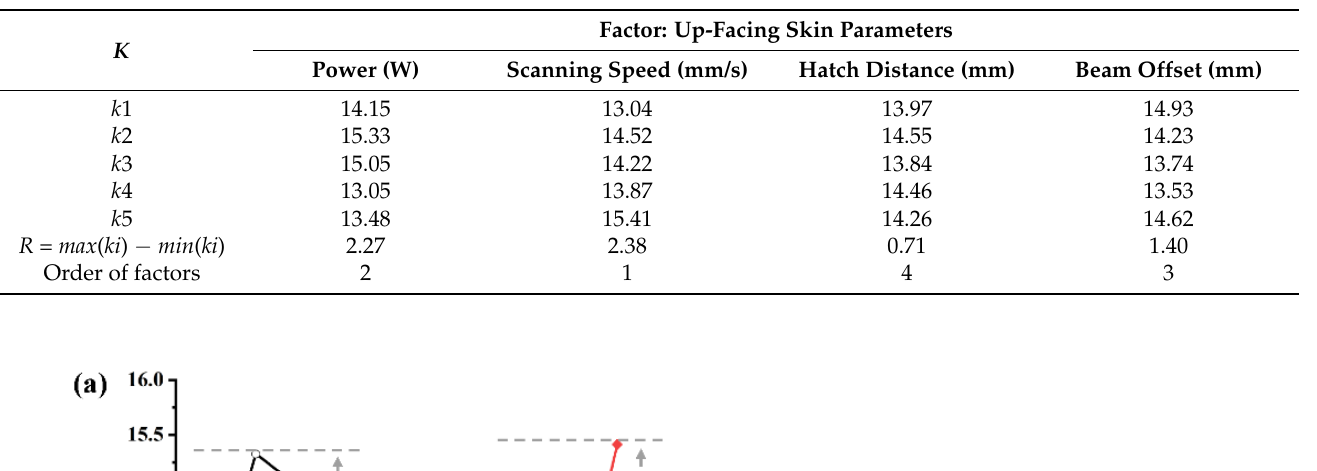
Table 5. Range analysis results of orthogonal test for up-facing skin roughness.